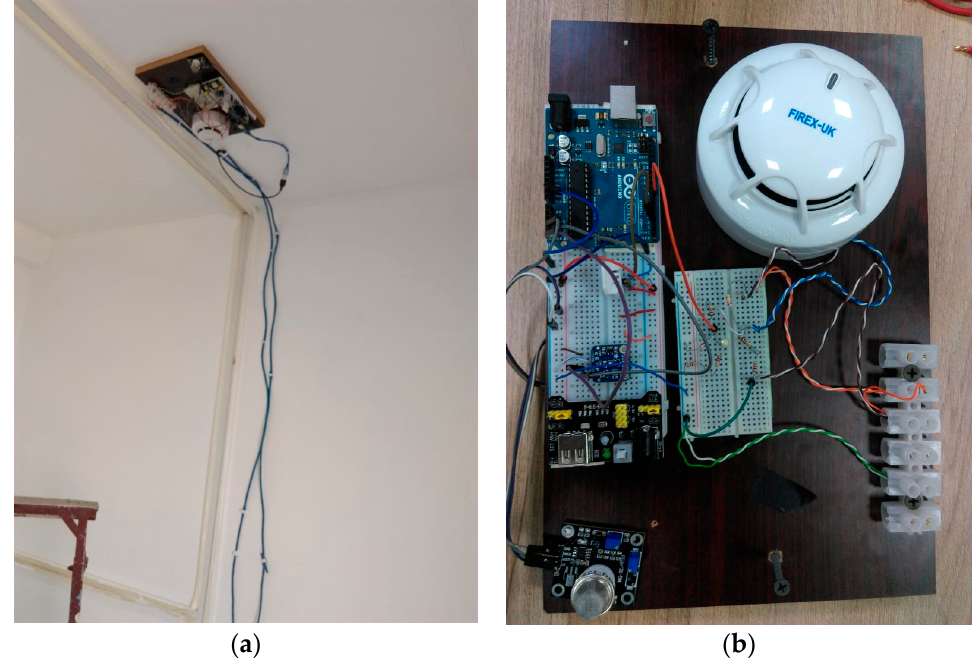
Figure 2. Hardware Deployment setup for Experiments: ( a ) setup physically situated in the middle of the laboratory room; ( b ) experimental setup showing sensors connected to the microcontroller motherboard and the LoRa Node wireless system connecting it to the cloud.